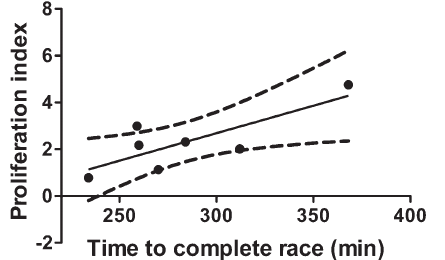
Figure 3. Correlation between lymphocyte proliferative response (proliferation index) and time to complete race. Data are reported as means±SD (dotted